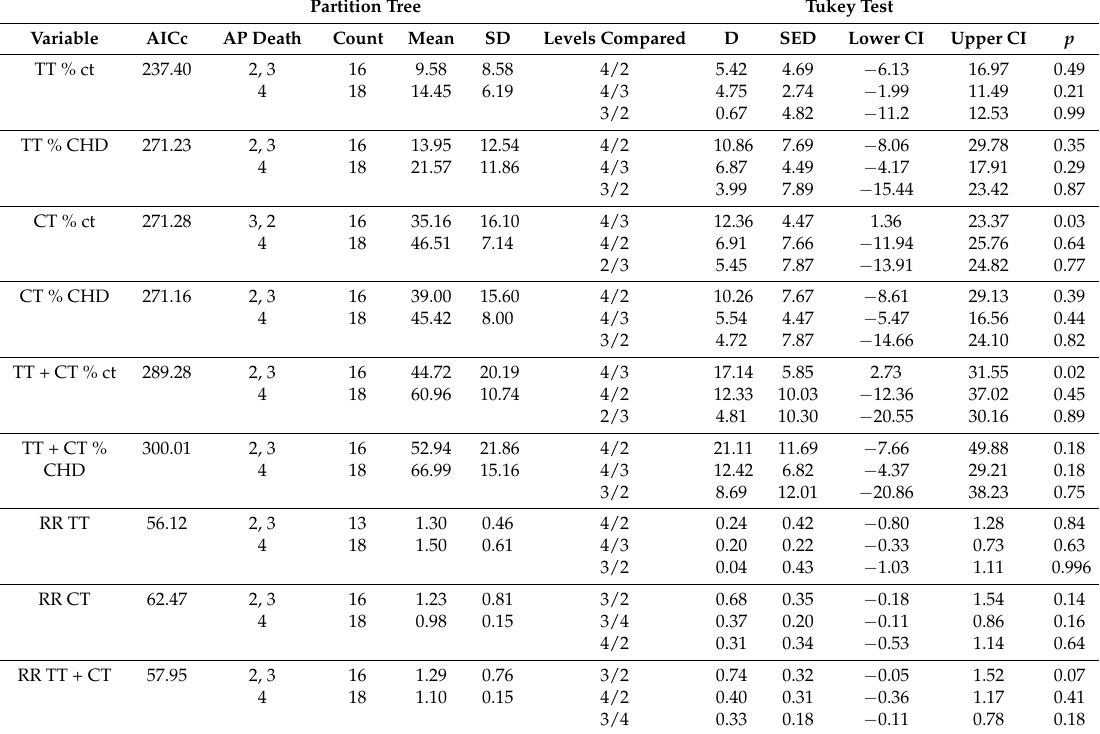
Table 4. Meta-prediction: Death from air pollution on MTHFR 677 genotypes for controls and congenital heart diseases (CHD) cases, and CHD risks for children (35 studies). Partition Tree Tukey